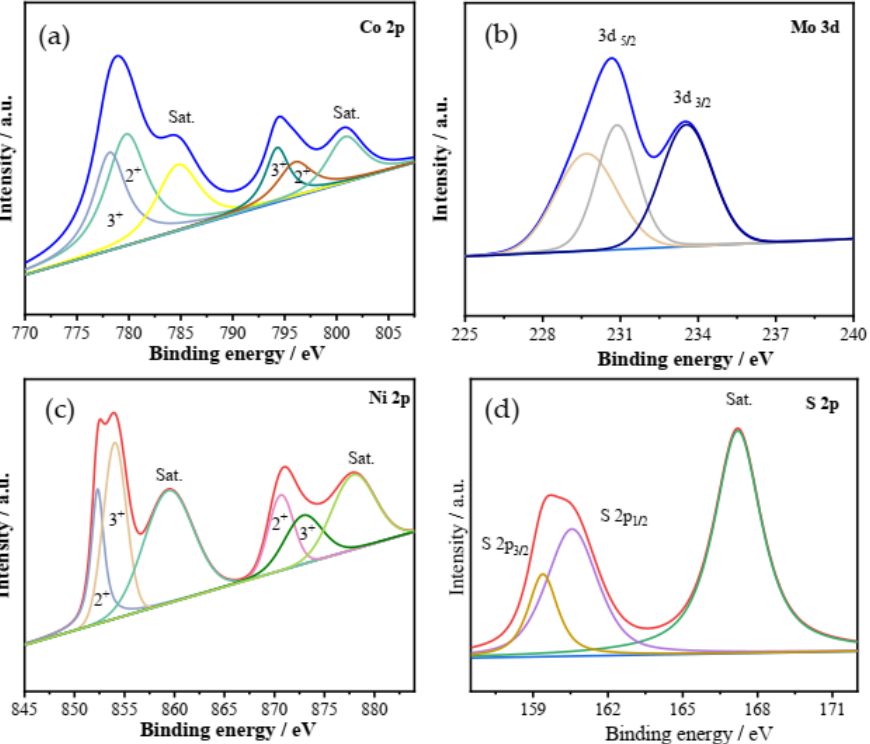
Figure 2. ( a ) XPS of Co 2p of the NiCo 2 S 4 @NiMoO 4 samples ( b ) Mo 3d of the NiCo 2 S 4 @NiMoO 4 samples ( c ) Ni 2p of the NiCo 2 S 4 @NiMoO 4 samples ( d ) S 2p of the NiCo 2 S 4 @NiMoO 4 samples